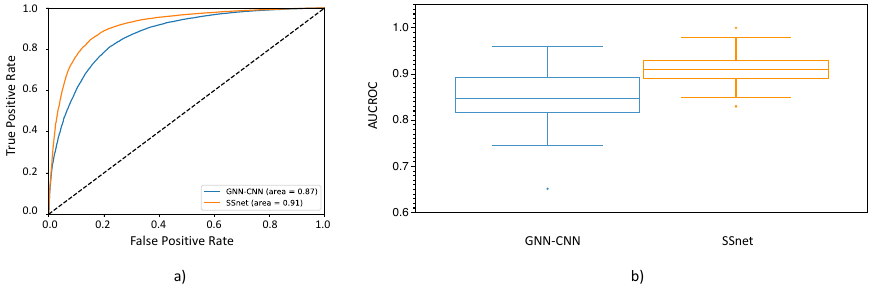
Figure 5. ( a ) ROC plot for the prediction of PLIs using micro-averaging. ( b ) Box and whisker plot for AUCROC for each individual target in the test set of of BindingDB